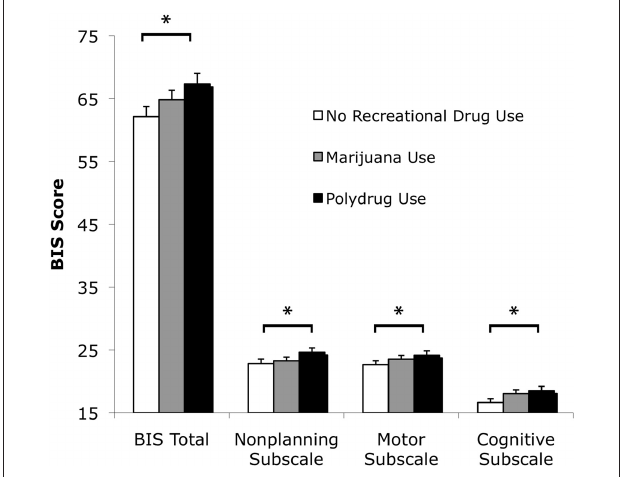
Figure 2 | recreational drug use and impulsivity. Individuals reporting polysubstance use ( n = 39), had significantly higher scores of impulsivity on the total BIS and Non-planning, Motor, and the Cognitive subscales than individuals reporting no recreational drug use ( n = 70; * p <